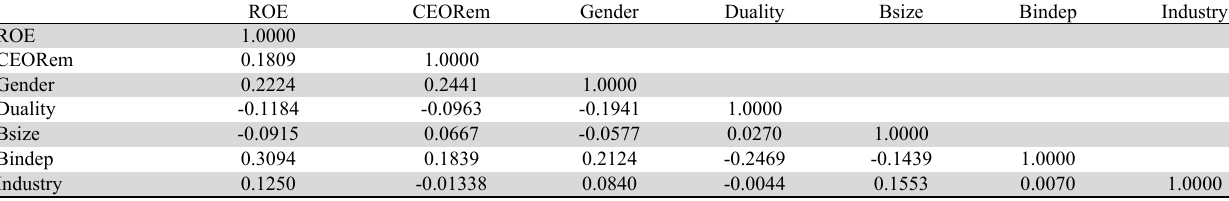
Correlation coefficients of variables related to the M1